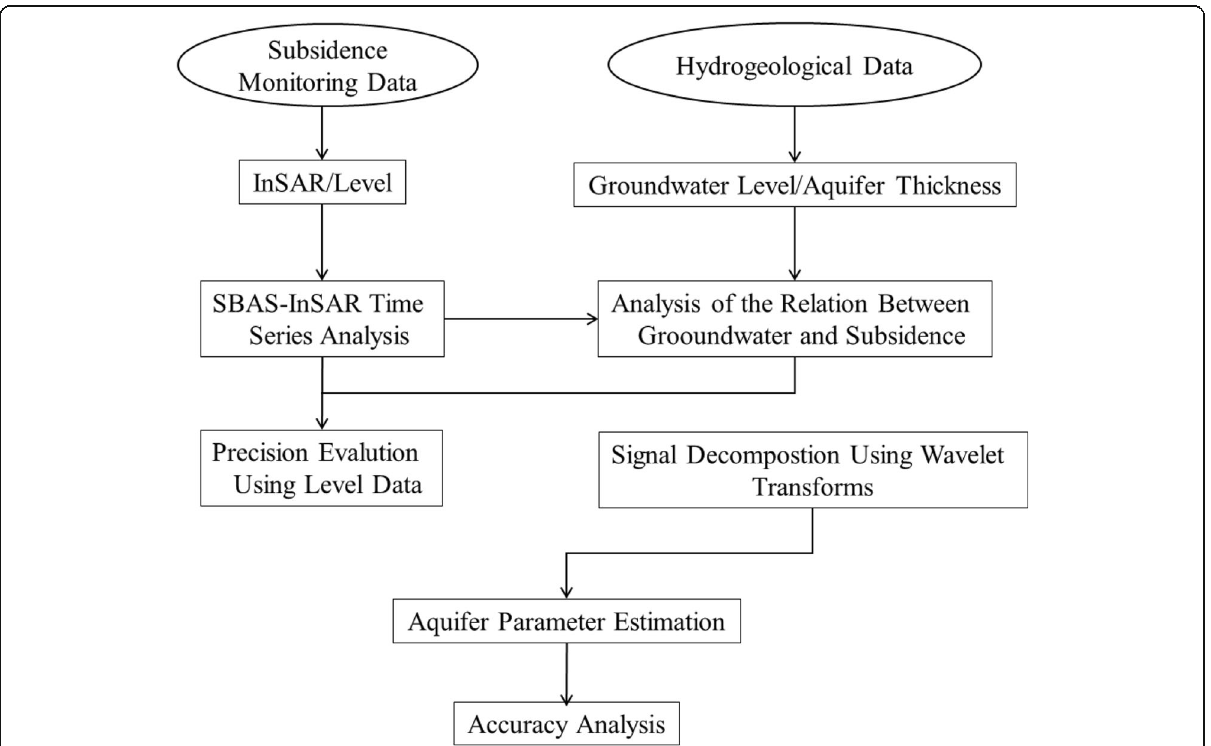
Fig. 1 Main technical flow chart of this